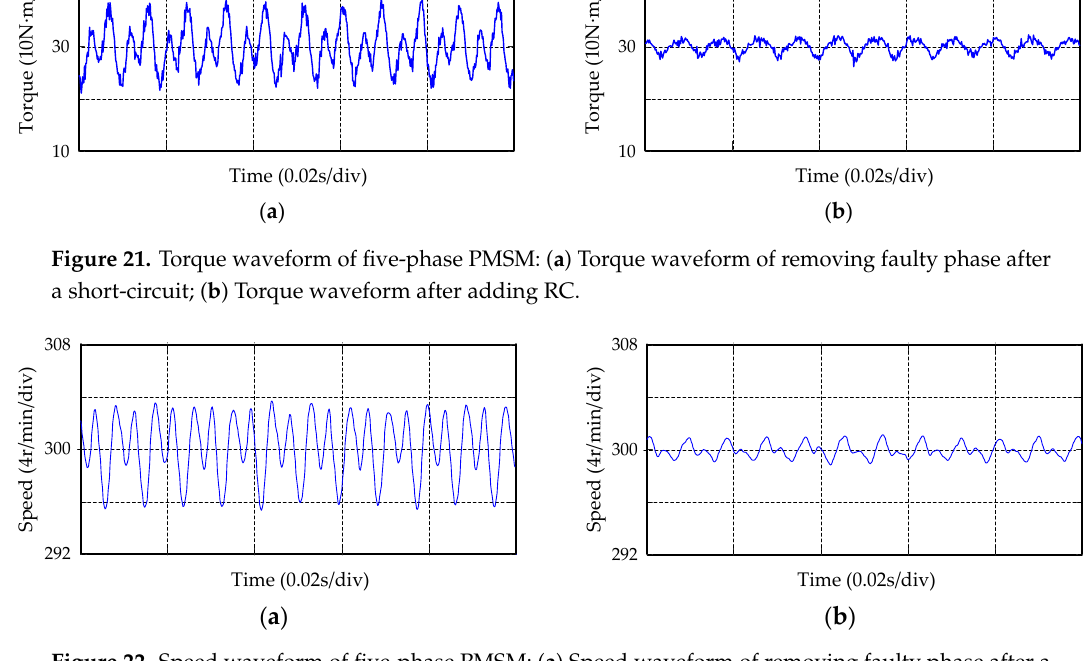
Figure 22. Speed waveform of five-phase PMSM: ( a ) Speed waveform of removing faulty phase after a short-circuit; ( b ) Speed waveform after adding RC.